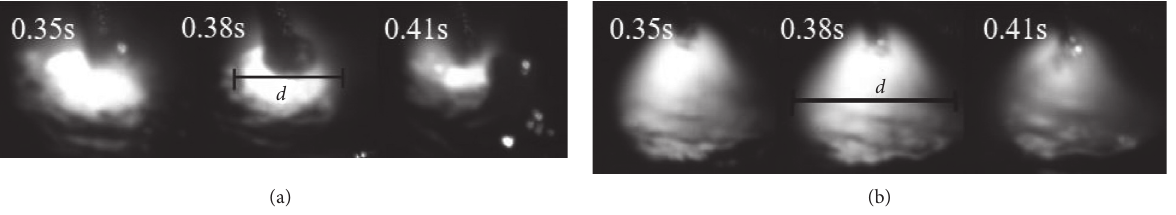
2 . (b) 95%Ar +5%CO 2 .